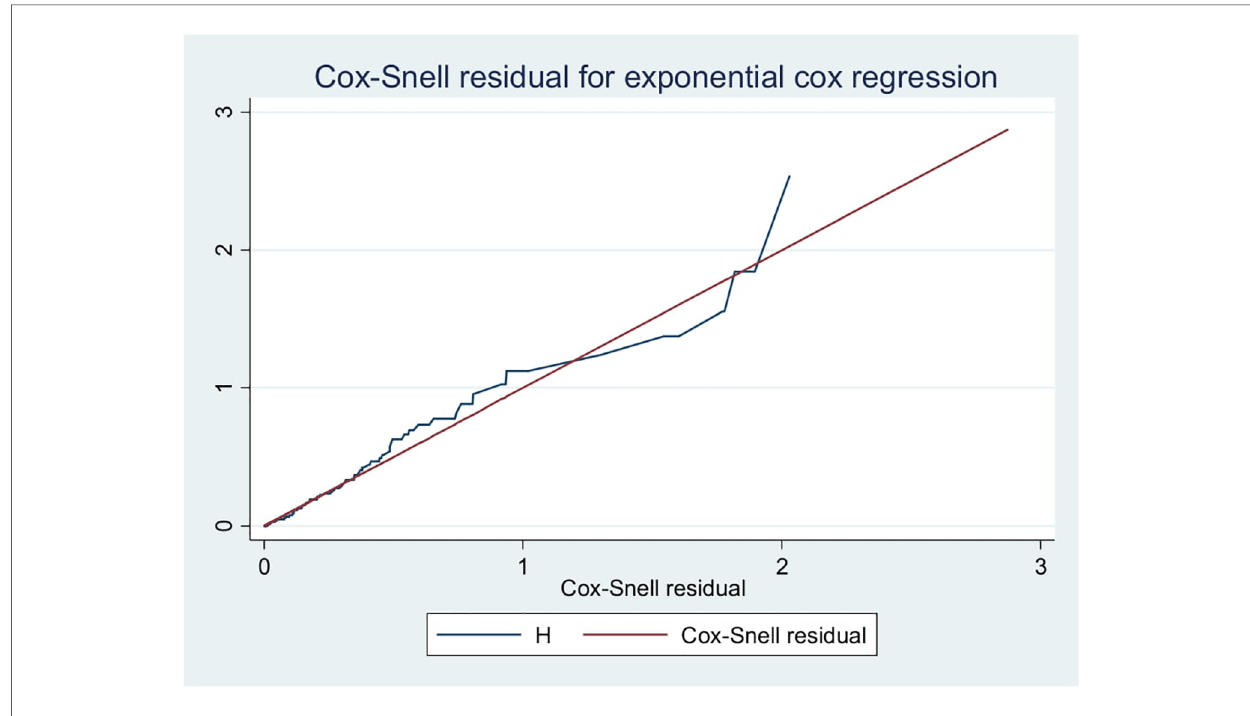
FIGURE 3 Cox-Snell residual test for overall adequacy of the model fi tted for time to death among neonates admitted with a diagnosis of neonatal